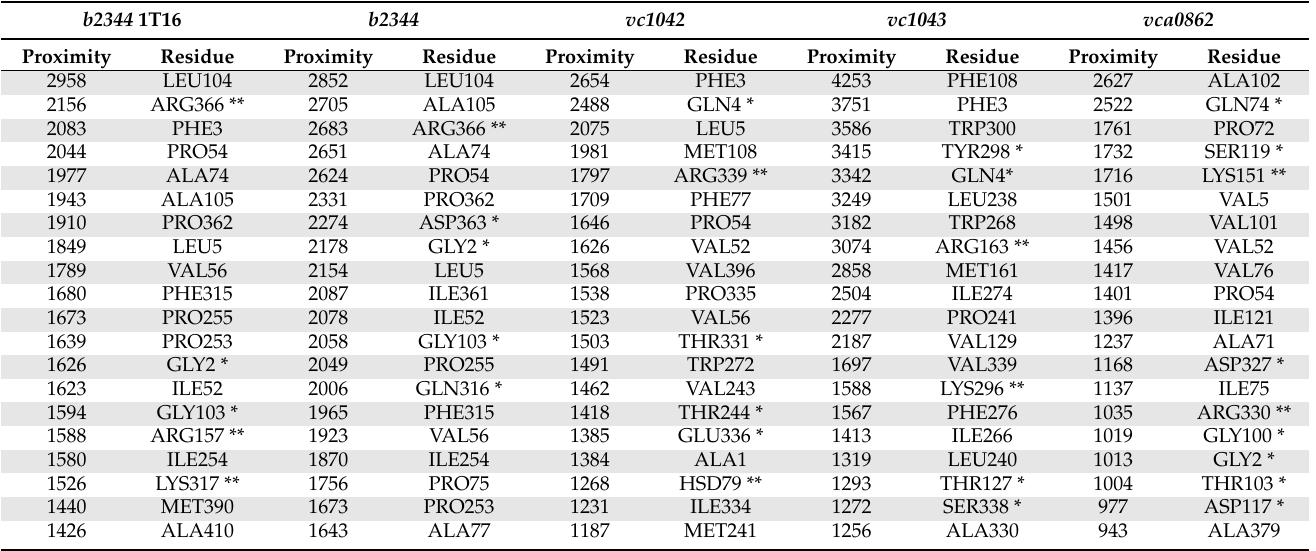
Table 1. Residue count for residues found within a 3 Åproximity of each FA for each frame. For each FadL homolog 100 FAs were docked for each of the 50 frames, giving a maximum residue count of